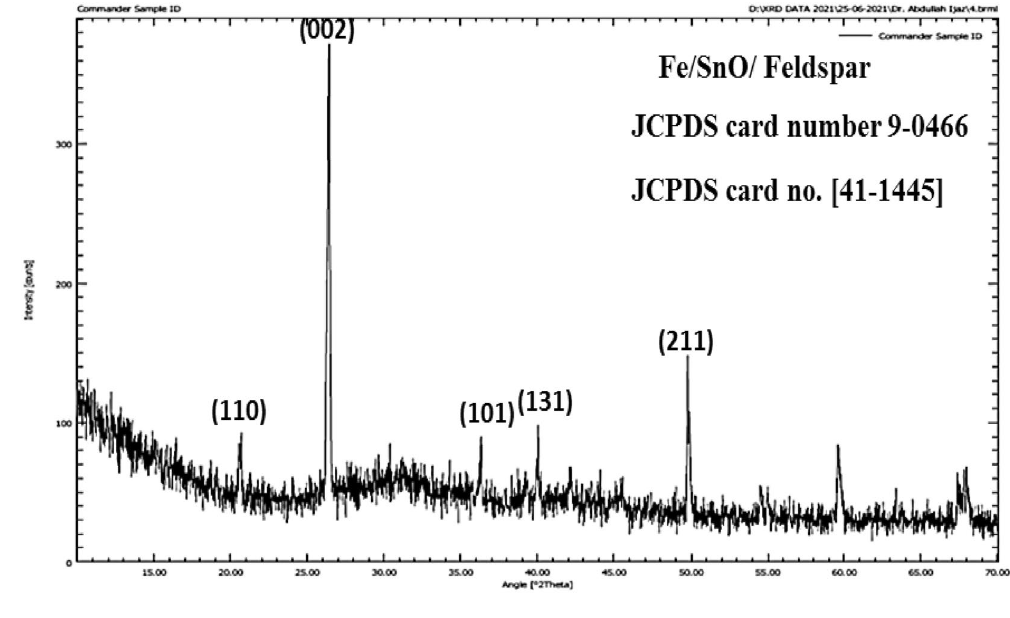
Figure 2. XRD of Fe/SnO/Feldspar.